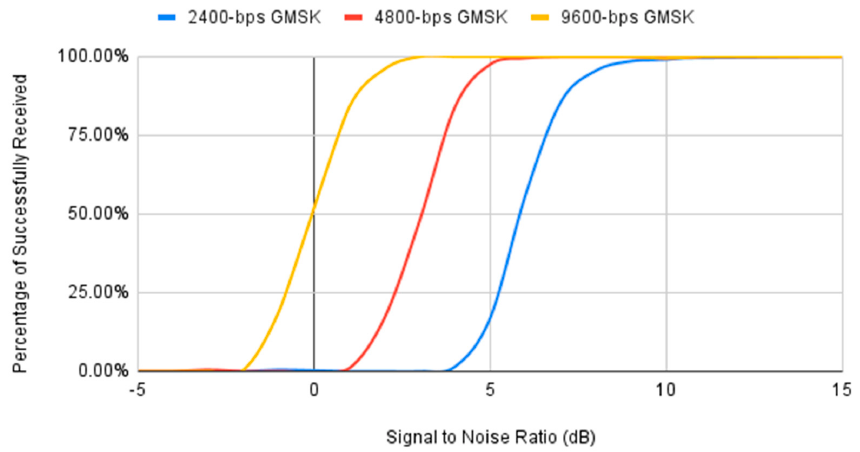
Figure 16. Packet success rate vs. a fixed signal-to-noise ratio of the system.